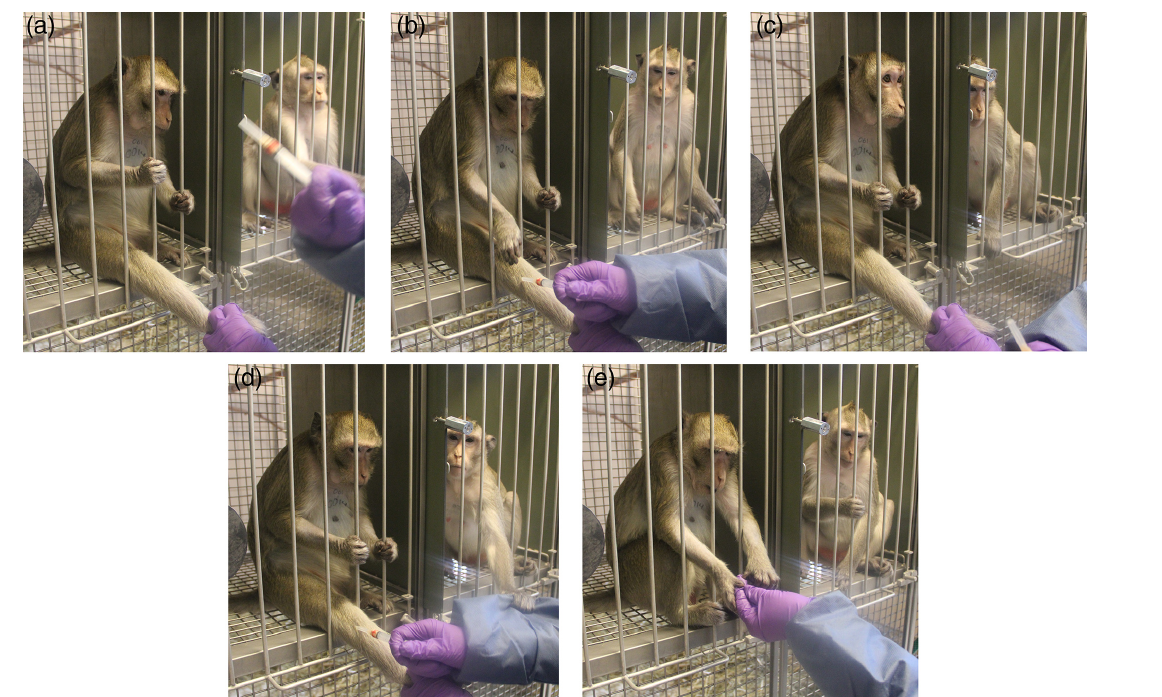
Figure 2. PRT training sequence in a long-tailed macaque (Macaca fascicularis). At this stage in training, the animal is already holding the bars, presenting the right leg and allowing the trainer to grasp it. (a) The trainer presents a capped syringe: the animal is holding on to the bars. (b) The animal lets go of the bars and reaches for the syringe, an unwanted behaviour. (c) The trainer withdraws the syringe; the animal recovers the desired position (holding the bars). (d) The trainer presents the syringe again; this time the animal holds on to the bars and accepts being touched by it. (e) The animal receives positive reinforcement: treats. Note that bar holding is a type of targeting (see below) and also a behaviour incompatible with reaching for the needle – it is impossible to do both at the same time. Unwanted behaviour is not simply ignored: removing the syringe (c) negatively punishes the unwanted behaviour (the chance of earning reinforcement is postponed). Also, at this stage of training there is no needle on the syringe. The neighbour is also keen on training but presently ignored. Image courtesy of Astrid Fagraeus